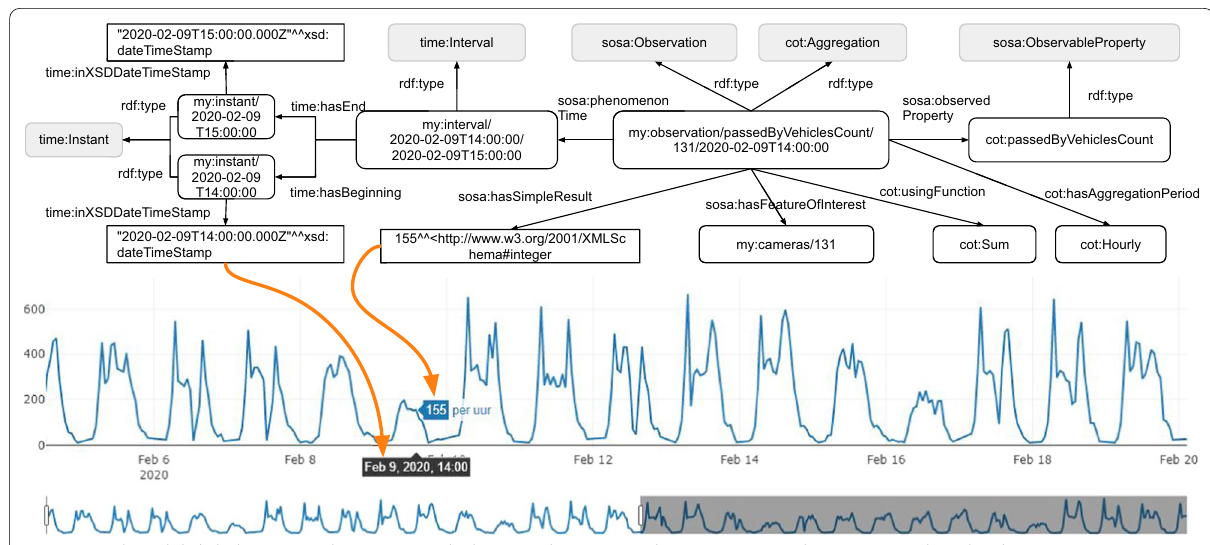
Fig. 6 Hourly and daily behavior visualization. 155 vehicles passed camera 131 between 2 pm and 3 pm on Tuesday 9th February 2020